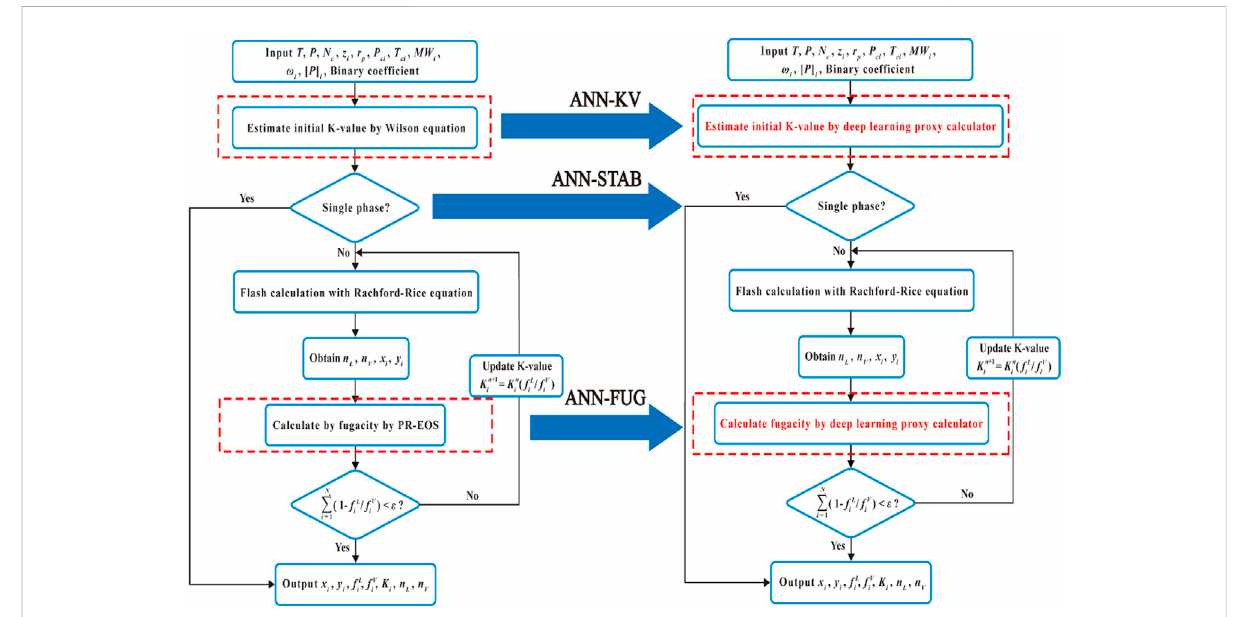
FIGURE 2 The schematic diagram of the DL-KF modeling and traditional fl ash calculation